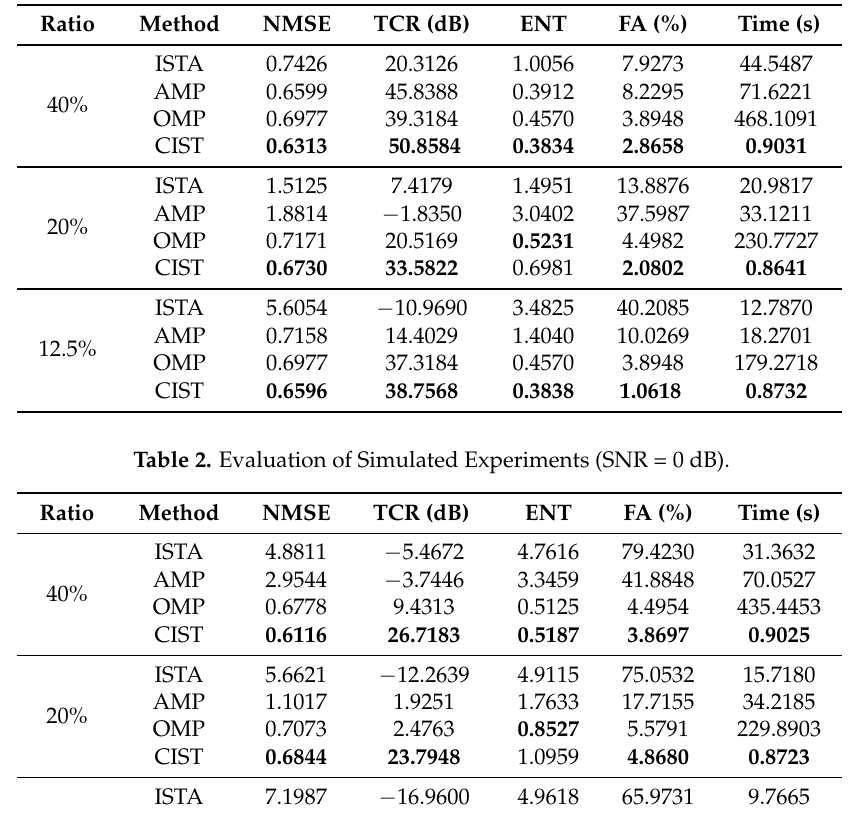
Table 1. Evaluation of Simulated Experiments (SNR = 20 dB).